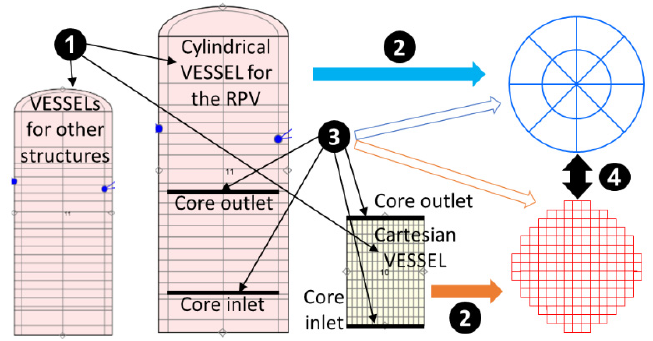
Figure 8. The main procedures during a multi-vessel coupling process.